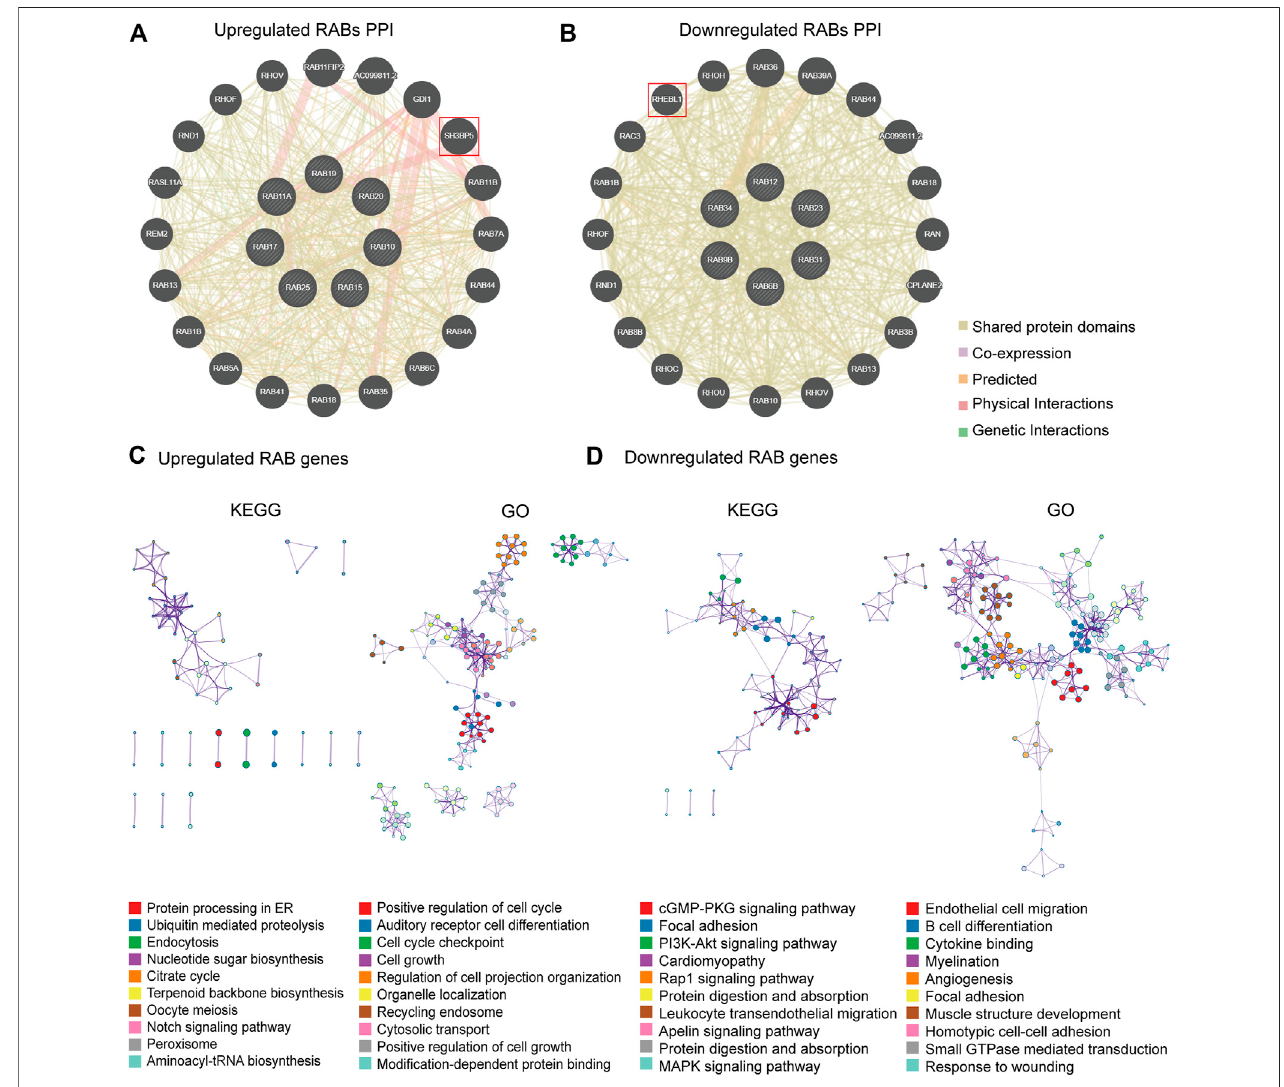
FIGURE 3 | PPI, KEGG, and GO enrichment analysis for RABs. (A – B) The protein interaction network of RABs related genes in CRC. (C – D) Top 10 enrichment terms in KEGG pathways and GO in RABs ( p -value of each pathway were shown in the Supplementary Tables S1 – 4